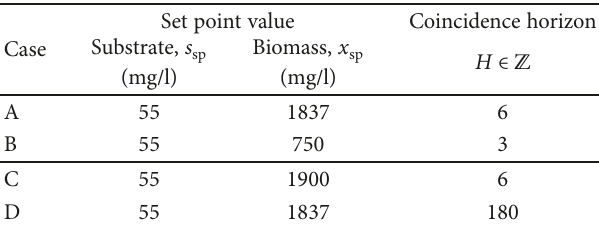
Algorithm 4: Control algorithm for FMBPC implementation. Table 10: Set points and H of experimental cases.